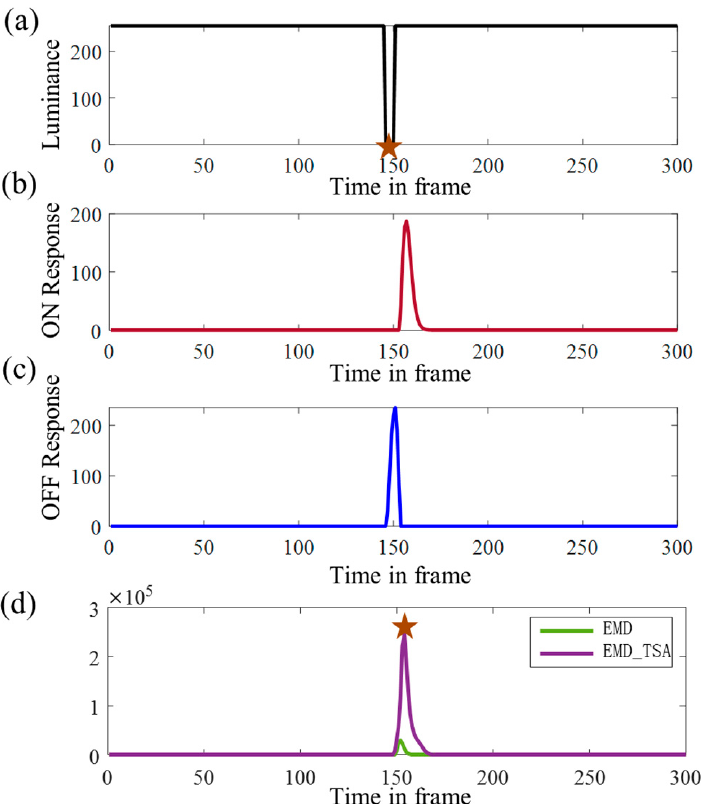
Figure 4. Outputs of various layers in the proposed model for a single moving target. ( a ) The input luminance signal L ( x 0 , y 0 , t ) . ( b ) ON response S ON of the proposed model. ( c ) OFF response S OFF of the proposed model. ( d ) The outputs of the EMD (green line) and EMD_TSA (purple line). The red asterisk marks the position of the moving target.